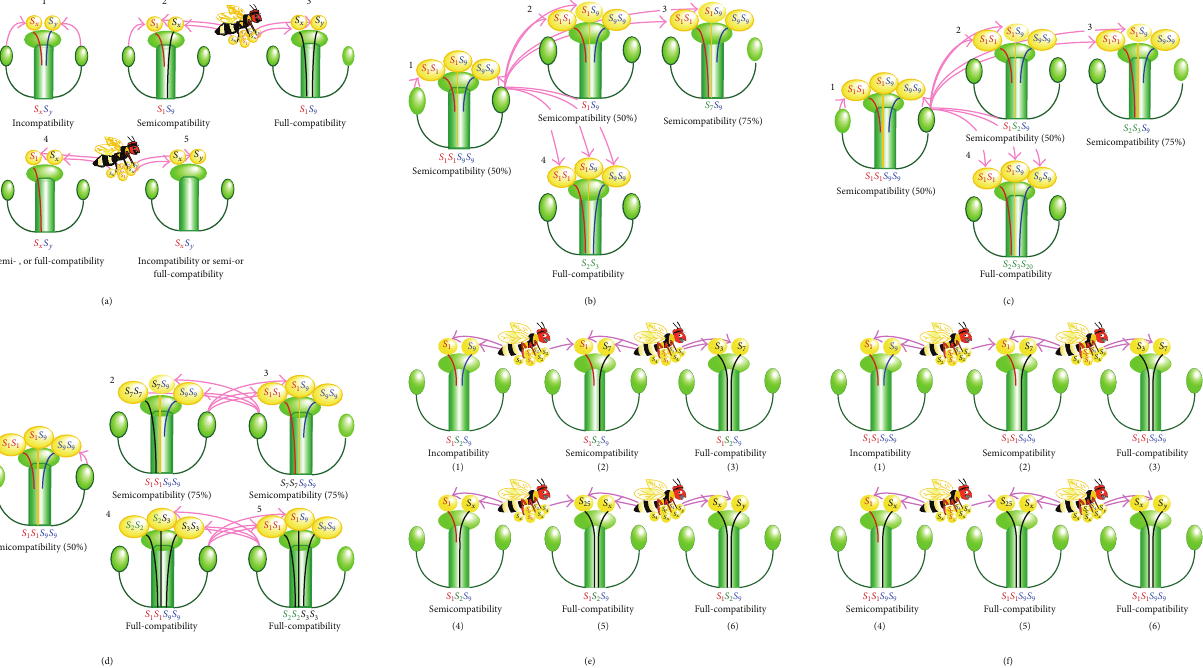
Figure 4: (a) Results of self-pollination of diploid “Dolgo” (1), diploid “Fuji” × diploid “Cox’s Pomona” (2), “Fuji” × “Dolgo” (3), “Dolgo” × “Cox’s Pomona” (4), and “Dolgo” × diploid “Pink Perfection” (5). (b) Results of self-pollination of tetraploid “Tensei” (1), diploid “Fuji” × “Tensei” (2), diploid “Jonathan” × “Tensei” (3), and diploid “Golden Delicious” × “Tensei” (4). (c) Results of self-pollination of tetraploid “Tensei” (1), triploid “Fukunishiki” × “Tensei” (2), triploid “Jonagold” × “Tensei” (3), and triploid “Mutsu” × “Tensei” (4). (d) Results of self-pollination of tetraploid “Tensei” (1), “Tensei” × tetraploid “Welday Jonathan” (2), “Welday Jonathan” × “Tensei” (3), “Tensei” × tetraploid “Doud Golden Delicious” (4), and “Doud Golden Delicious” × “Tensei” (5). (e) Results of triploid “Fukunishiki” × diploid “Fuji” (1), “Fukunishiki” × diploid “Shinano Sweet” (2), “Fukunishiki” × diploid “Tsugaru” (3), “Fukunishiki” × diploid “Cox’s Pomona” (4), “Fukunishiki” × diploid“Snowdrift”(5),and“Fukunishiki” × diploid“Dolgo”(6).(f)Resultsoftetraploid“Tensei” × diploid“Fuji”(1),“Tensei” × diploid “Shinano Sweet” (2), “Tensei” × diploid “Tsugaru” (3), “Tensei” × diploid “Cox’s Pomona” (4), “Tensei” × diploid “Snowdrift” (5), and “Tensei” × diploid “Dolgo”